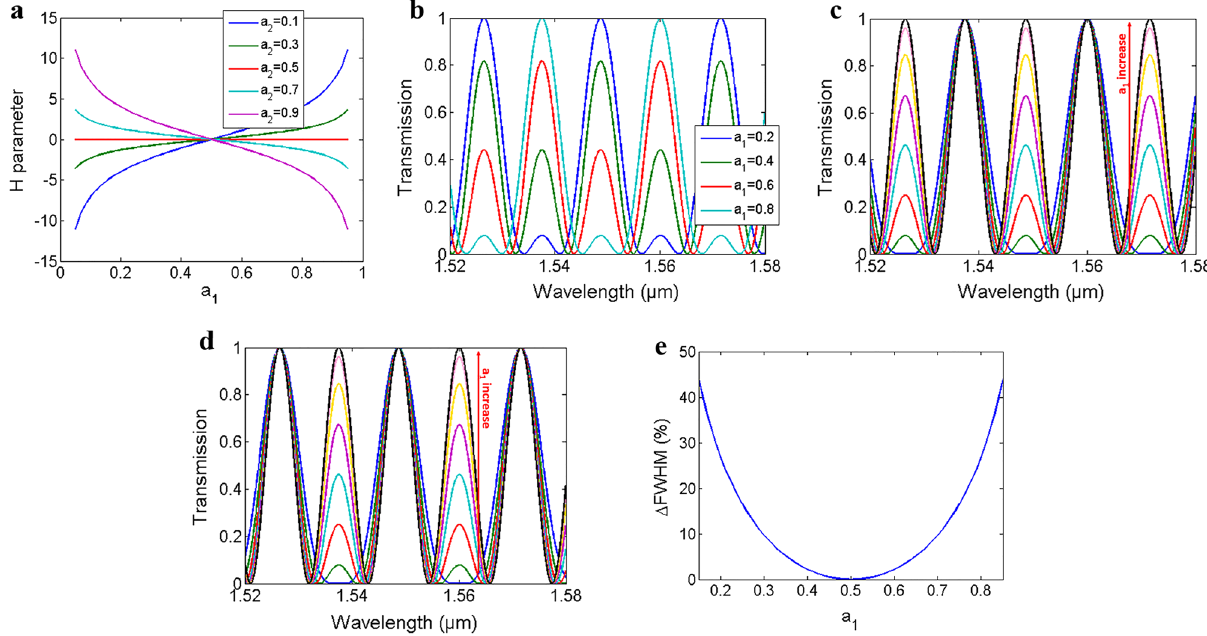
Figure 5. ( a ) H parameter versus a 1 coefficient at different a 2 . Transmission spectrum versus wavelength of SOI waveguide TE mode at w = 500 nm and ΔL = 25.4 µm with: ( b ) a 2 = 0.8 at different a 1 , ( c ) at different a 1 with a 2 = a 1 and ( d ) at different a 1 with a 2 = 1 − a 1 where a 1 increase from 0.15 to 0.5 with 0.05 step as indicated by the arrow. ( e ) Percentage change of the main loop FWHM versus a 1 for part c and